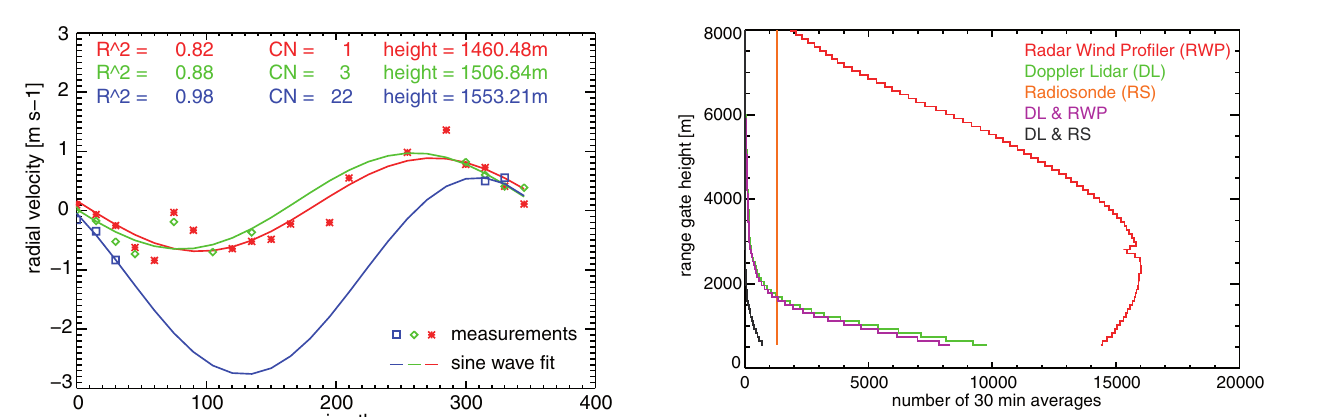
Figure 7. Examples of three sine wave fits used to reconstruct the 30 min averaged wind profiles shown in Fig. 4 at the three adja- cent heights h 1 = 1460 . 48m, h 2 = 1506 . 84m and h 3 = 1553 . 21m for the single time stamp 12:02 UTC. Additionally for each fit the quality control parameters R 2 and CN are also given. The sine wave fit at h 3 has a high R 2 but due to the large azimuthal gap size within the measurements the condition number CN is relatively high, in- dicating a high degree of multicollinearity. The latter results in im- plausible magnitudes of the wind speed yielding unphysical vertical gradients in the wind speed field (see also the outstanding red pixel in the wind speed profile shown in Fig. 4 at the time stamp 12:02 UTC).